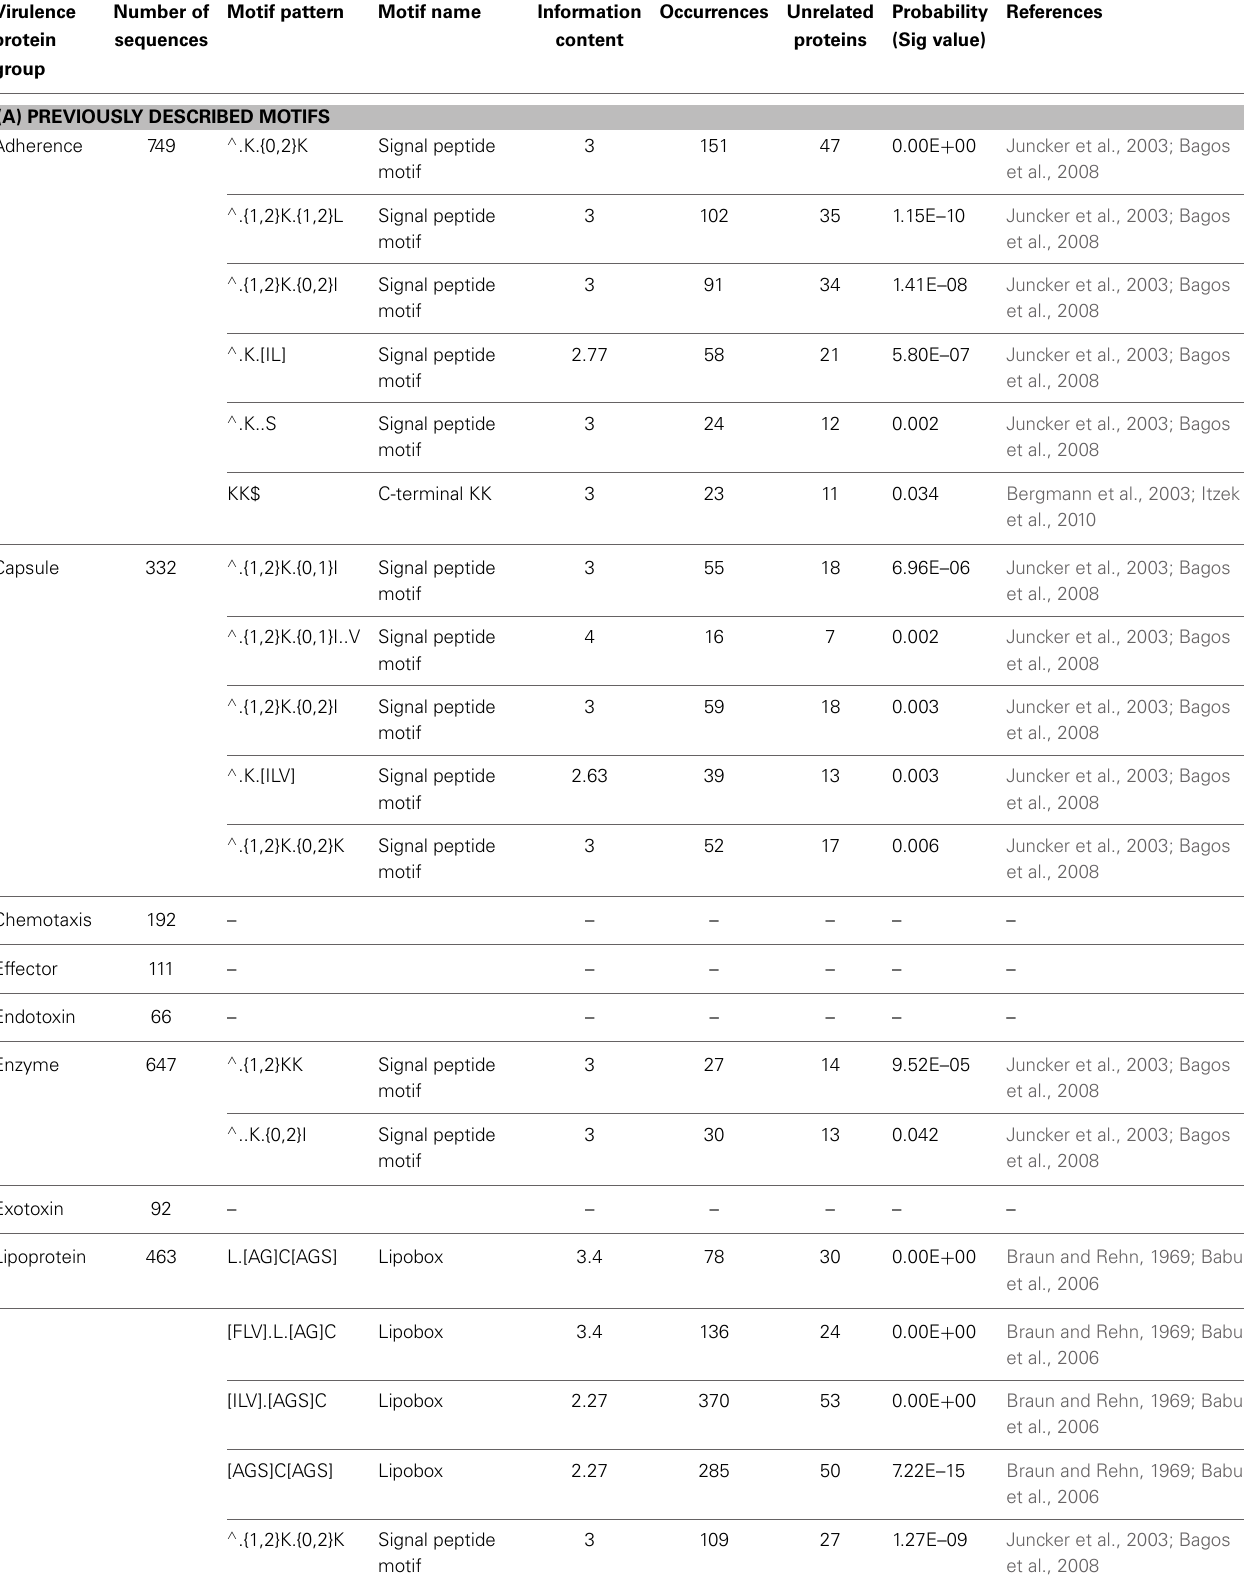
Table 3 | Significant motifs returned by SLiMFinder in each dataset (where probability <